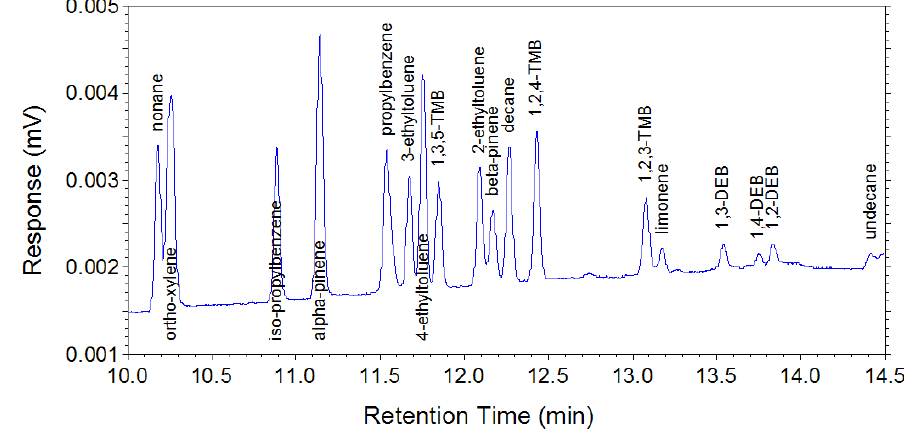
Fig. 2. Portion of a chromatogram from the THF GC system primary working standard showing identification of compounds that eluted between nonane and undecane on the VF-5ms column. The temperature program employed was 35 ◦ C for 2min, 10 ◦ C min − 1 to 115 ◦ C,